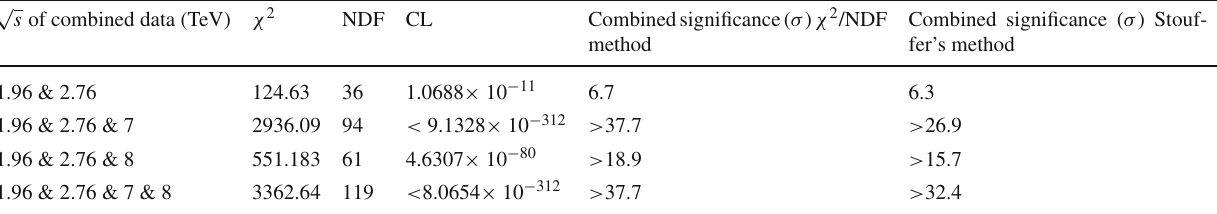
Table 2 Summary on combined Odderon signal observation significances in the ReBB model analysis. The significances higher than 8 σ were calculated by utilizing an analytical approximation detailed in Appendix A √ s of combined data (TeV) χ 2 NDF